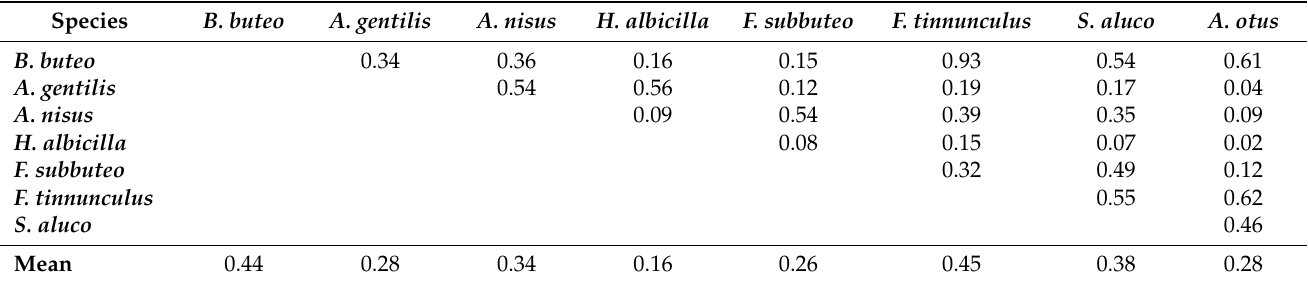
Table 3. The food niche overlap of avian predators in the breeding season in the area of study (central Poland, vicinity of Rog ó w village, Experimental Forest Station of Warsaw University of Life Sciences), based on pellet analysis and prey remains collection and calculated with a Pianka formula